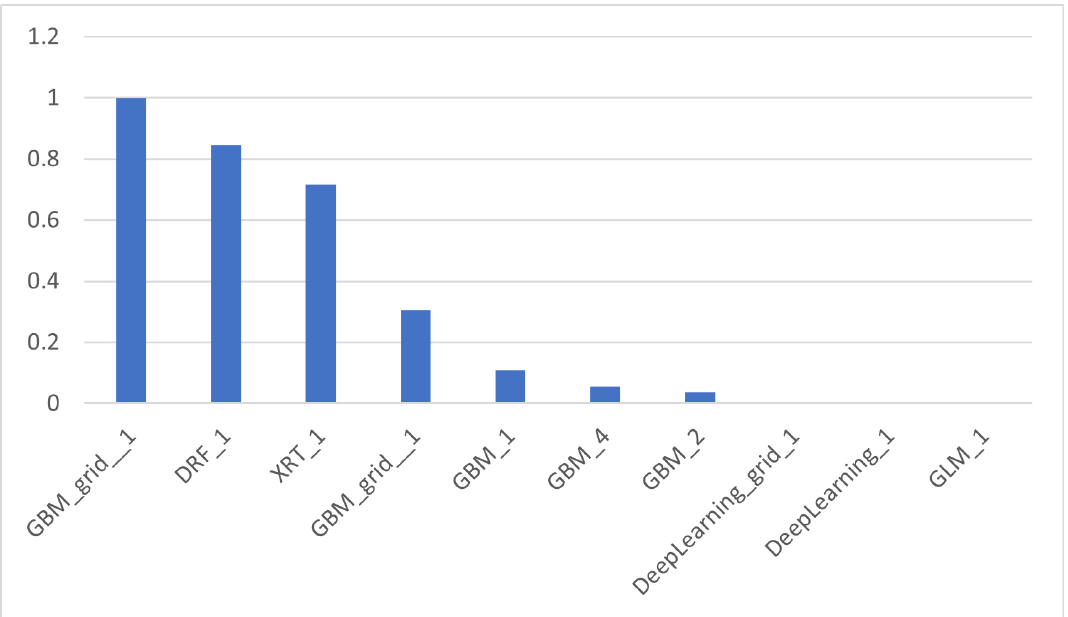
Figure 14. Performance of the AutoML algorithms.